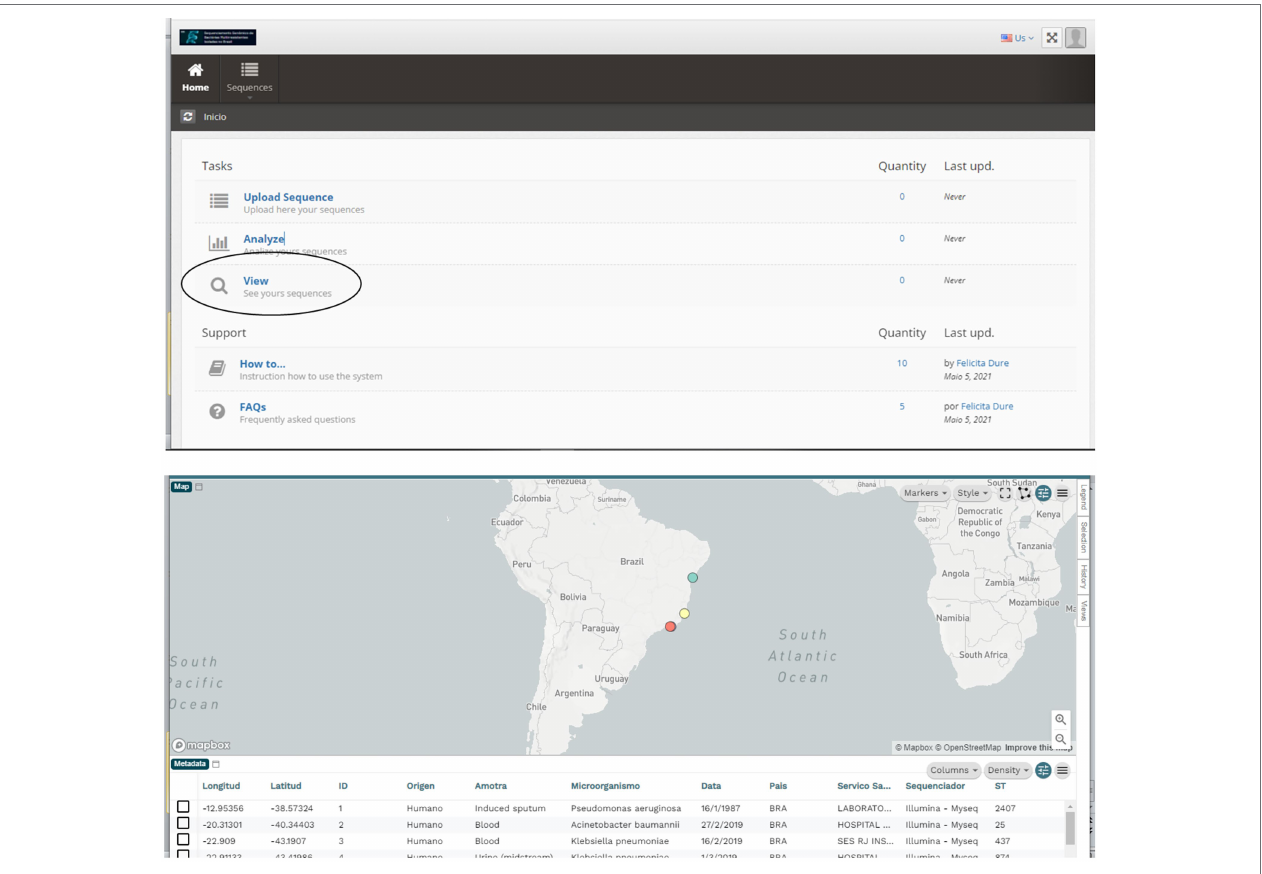
FIGURE 4 | From the Main Menu, in the Queries Task, you can access all the sequenced data. This visualization is done with the Microreact program, which allows visualizing and exploring any combination of grouping (trees), geographic (map), and temporal (timeline) data. Other metadata variables are displayed in a